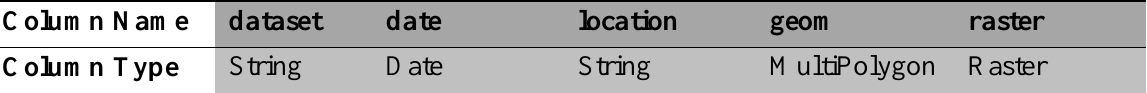
Table 5. Database table structure for MODIS time-series data.